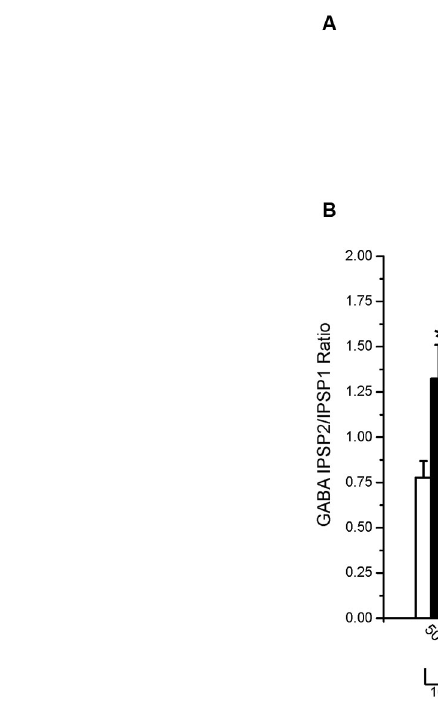
FIGURE 3 | MT-7716 decreases GABAergic transmission in CeA neurons by decreasing GABA release. (A) Representative recordings of PPF at both 50 (upper traces) and 100 (lower traces) ms in a CeA neuron from naïve rat before and during superfusion of 250 nM MT-7716. (B) Overall ANOVA revealed that MT-7716 (100 and 250 nM)